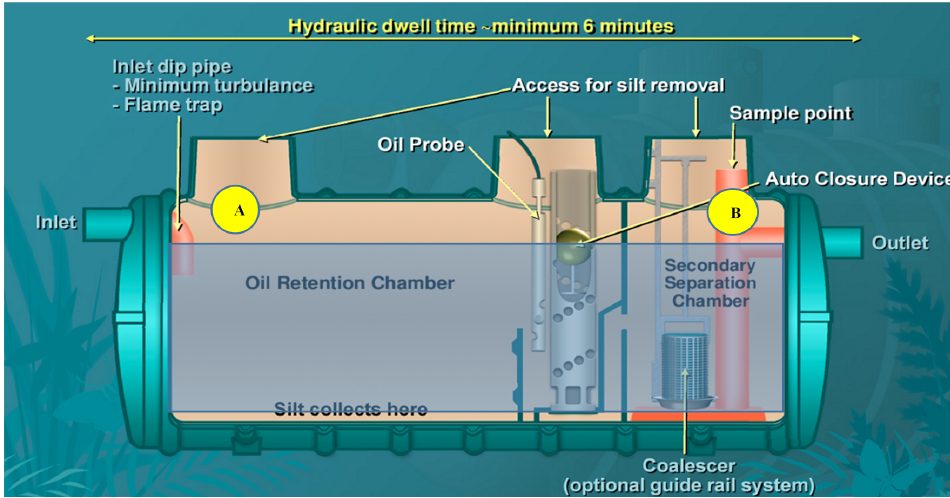
Figure 6. Section through treatment device showing sample points at inlet ( A ) and outlet ( B ).